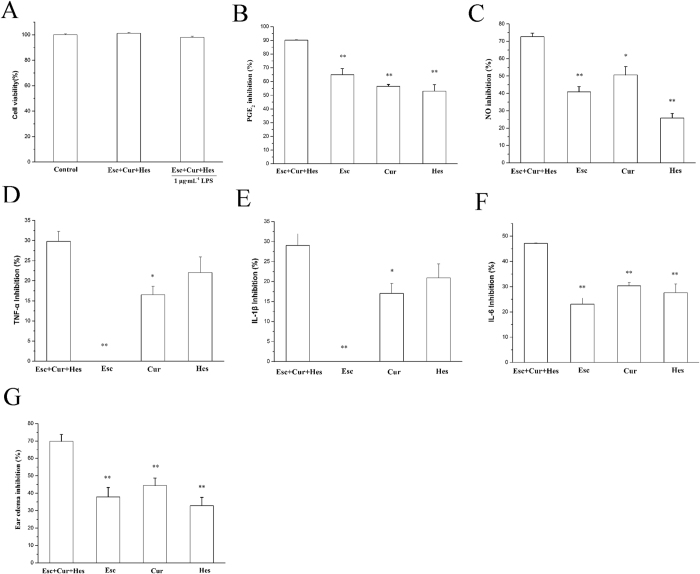
The inhibition on the production of inflammatory mediators, cytokines and ear edema after treatment with the combination and each compound of Esc, Cur and Her at the indicated optimal concentrations.(A) Cytotoxic effects of the combination of Esc, Cur and Her at the indicated optimal concentrations. Raw264.7 cells were treated with the combination of Esc 11.6 μM, Cur 8.5 μM, and Hes 12.5 μM alone or followed by 1 μg·mL−1 LPS for 24 h. Cells were then subjected to MTT assay as described in the Methods. (B–F) The inhibition on the production of PGE2 (B), NO (C), TNF-α (D), IL-1β (E) and IL-6 (F) after treatment with the combination and each compound of Esc, Cur and Her at the indicated optimal concentrations of 11.6 μM, 8.5 μM and 12.5 μM, respectively. (G) The inhibition on croton oil-induced mouse ear edema after treatment with the combination and each compound of Esc, Cur and Her at the indicated optimal dosage of 337 mg·kg−1, 60 mg·kg−1 and 191 mg·kg−1, respectively. All values are presented as the mean ± S.E. and are the result of three independent experiments. *p < 0.05, **p < 0.01 as compared to Esc+ Cur+Hes group. (Esc+ Cur+Hes represent combination of Esc, Cur and Hes).